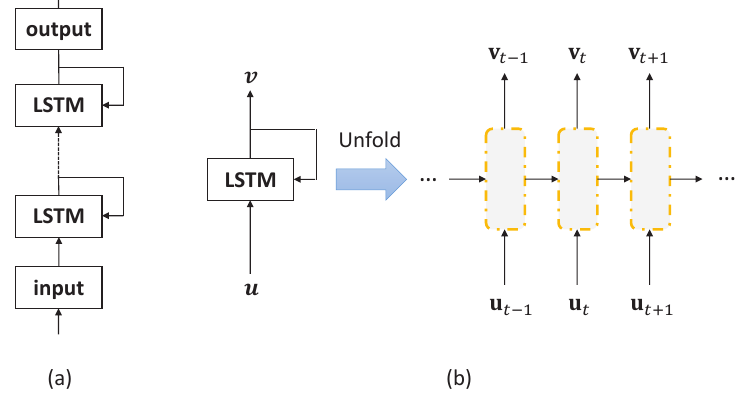
Figure 5. The configuration of LSTM-RNN. ( a ) The deep LSTM-RNN; ( b ) The configuration of LSTM memory blocks that unfolded across time.